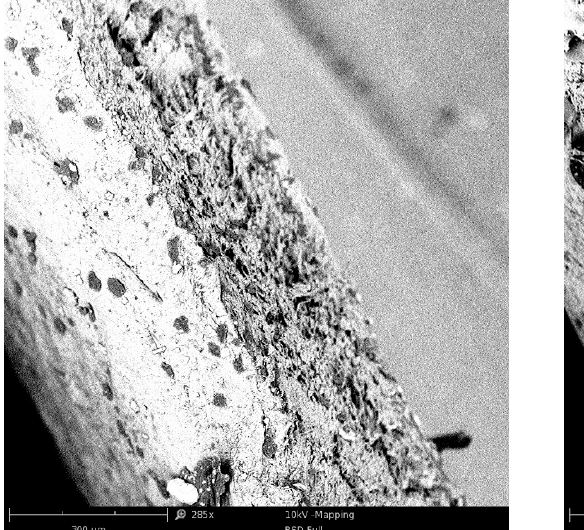
Figure 7. Scanning electron micrographs of the PVC single coatings: ( a ) PVC + 0.2% BA; ( b ) PVC + 0.6% BA.